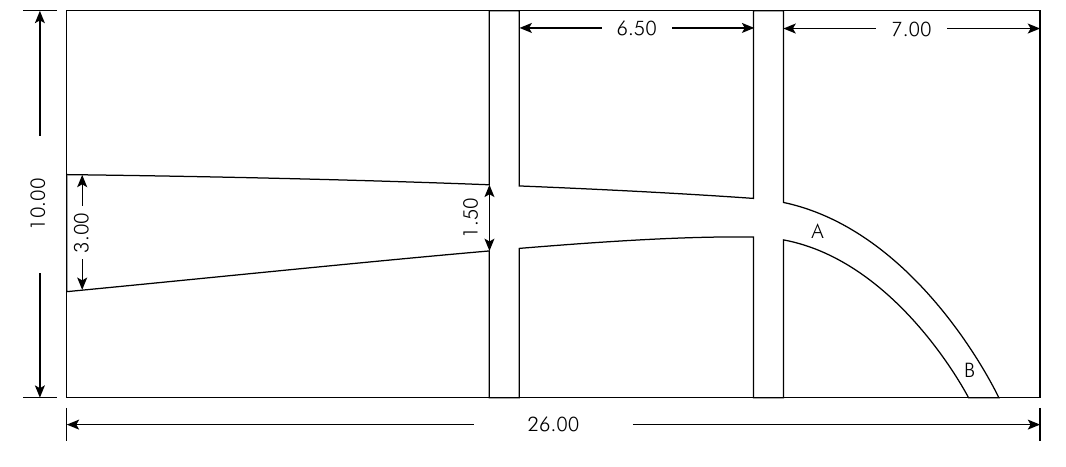
Figure 1. Drawing of an artificial simulated root canal showing lateral canals in the middle and apical